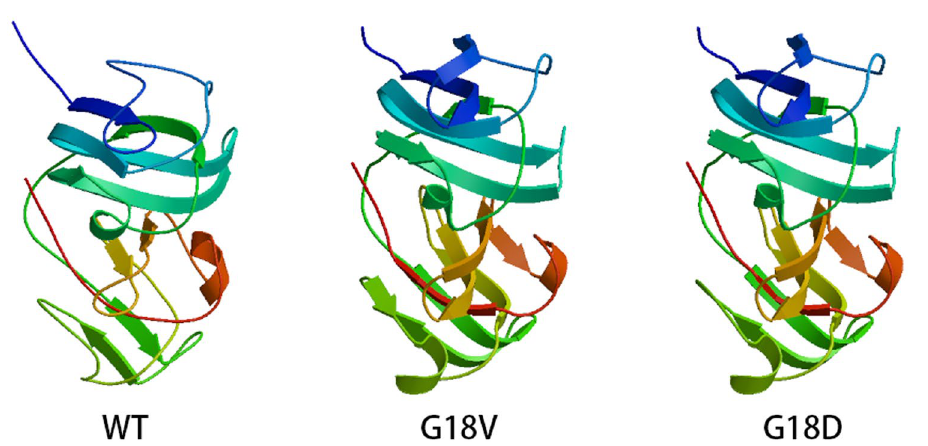
Figure 4. Stuctural modeling of WT, p.G18V and p.G18D crystallin gamma S using